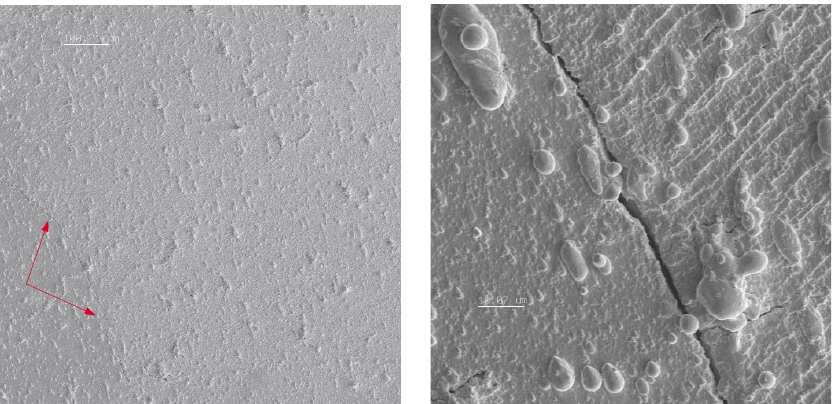
FIG. 20. (Color) Grain-boundary cracks in the area of maximum temperature rise. The grain boundary is the transition between the two different textures on the surface shown by the red arrows. The texture on the right-hand side of the picture on the left is due to slip bands. A close-up of one crack is in the right-hand picture where the grain boundary is clear. The length scales are 100 : 7 (cid:3) m and 10 : 1 (cid:3) m , respectively.